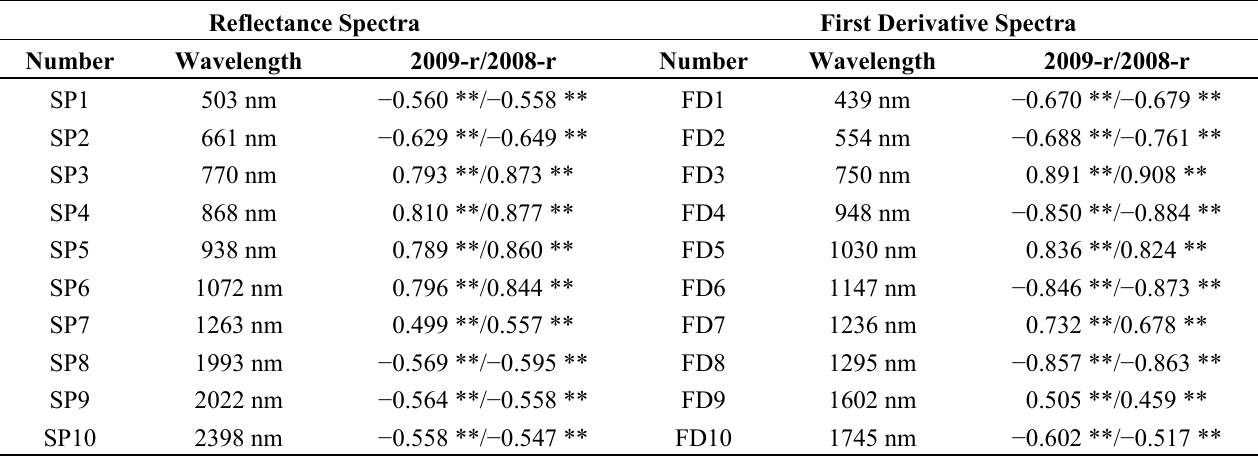
Table 4. Correlations between optimal spectral waveband features and LAI in different